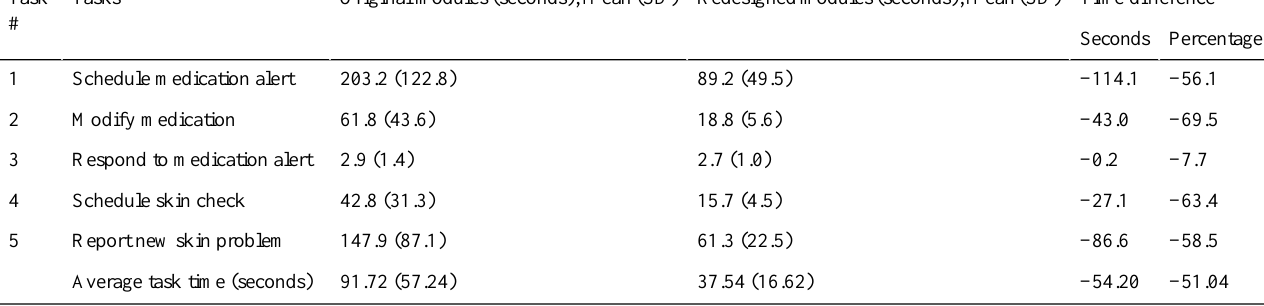
Table 4. Individual task time: average time needed to complete individual tasks.